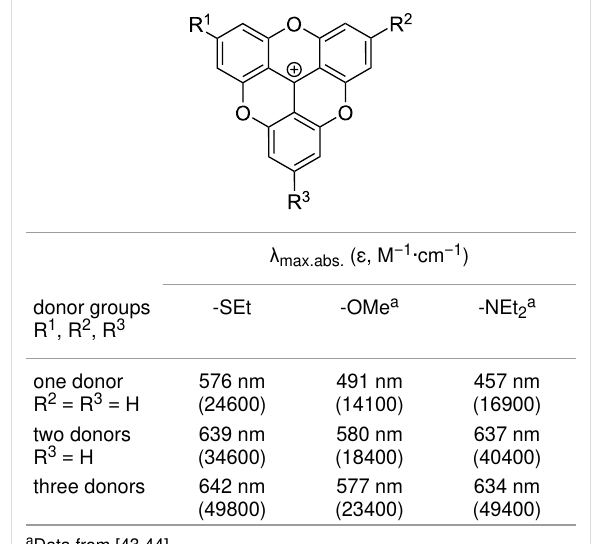
Table 1: Summary of absorption data of triarylmethylium ions in